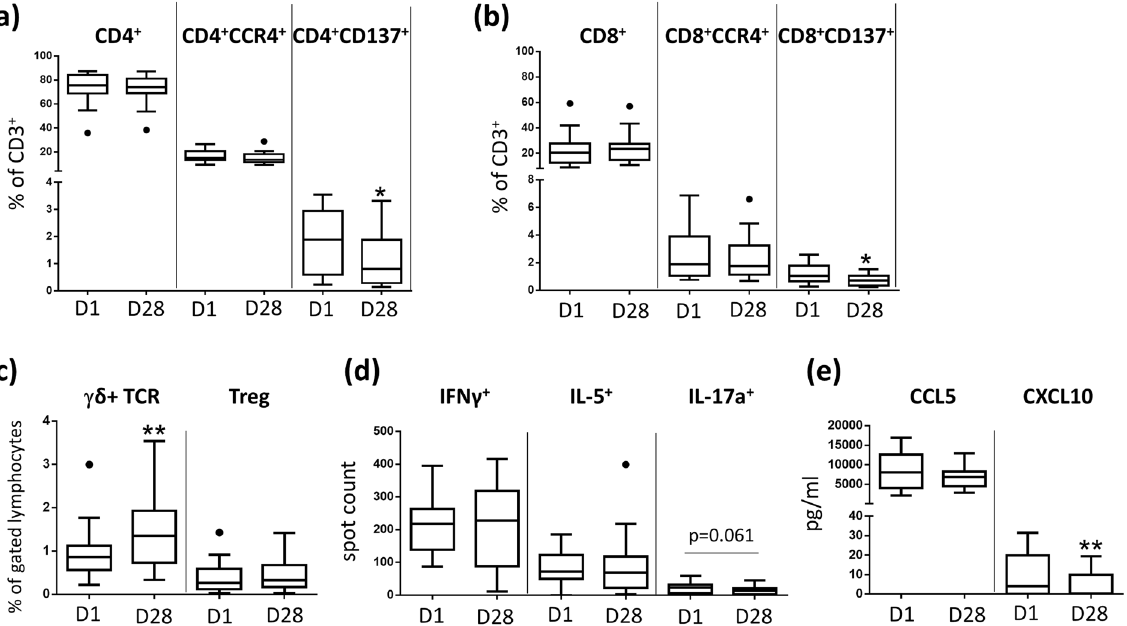
Figure 3. PDT induces systemic anti-inflammatory effects in OLP. ( a ) Relative number of CD137 expressing peripheral blood CD4 + T- cells is decreased 14 days after PDT treatment. Results based on analysis by flow cytometry. ( b ) Relative number of CD137 expressing peripheral blood CD8 + T- cells is decreased 14 days after PDT treatment. Results based on analysis by flow cytometry. ( c ) PDT leads to an increase of the relative number of peripheral blood γδ T cells. Results based on analysis by flow cytometry. ( d ) Number of peripheral blood IL- 17a producing T cells is decreased 14 days after PDT treatment. Results based on ELISpot. analysis. (e) CXCL10 plasma levels are decreased 14 days after PDT treatment. Results based on ELISA analysis. * p < 0.05, ** p < 0.01. PDT, photodynamic treatment.